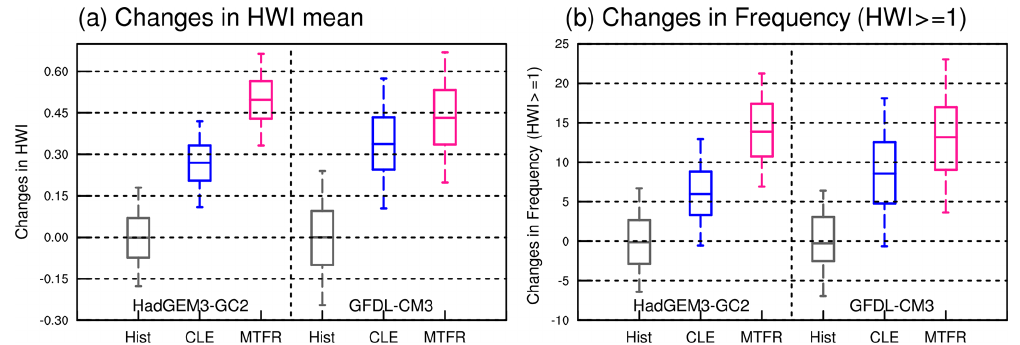
Figure 4. Box plots for the 5000 bootstrapped samples of (a) changes in winter mean HWI and (b) frequency of month with HWI ≥ 1 in HadGEM3-GC2 and GFDL-CM3. The grey, blue and pink boxes are results estimated from His, CLE and MTFR, respectively. Boxes show the interquartile ranges of the 5000 bootstrapped samples, and black lines show the median. End points are the 5th and 95th percentiles. A significant difference is seen when the median from one experiment falls outside the interquartile range of another.